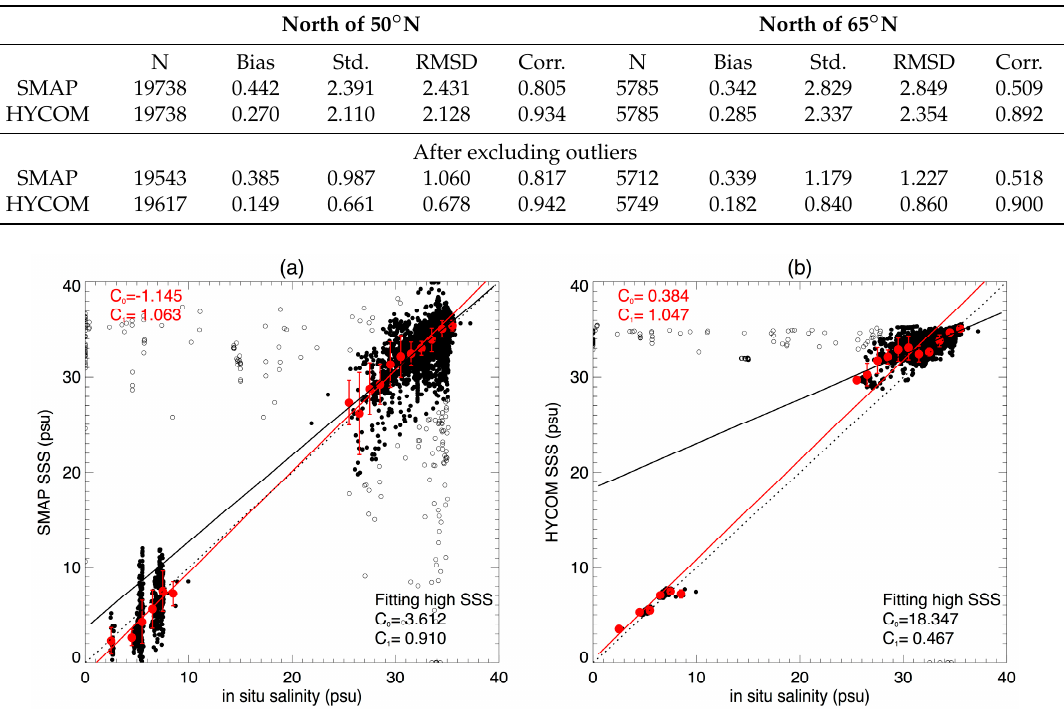
Figure 3. Scatterplot of in situ salinity collected within 5 m from surface and collocated data of ( a ) SMAP SSS and ( b ) HYCOM SSS. Collocations are based on gridded data on 0.25 ◦ grids averaged daily from April 2015 to March 2018. The three clusters associated with low in situ salinity (2–7 psu) are located in the Gulf of Bothania and the Baltic Sea. Open circles indicate where the absolute difference between the pair exceeds three times of the standard deviation. Linear regression of all data (excluding outliers) bin-averaged in terms of in situ SSS (bin size of 1 psu) is illustrated in red with zero intercepted denote by C 0 and slope by C 1 , while the regression of high SSS (>25 psu, excluding outliers and the low salinity clusters.) is illustrated in black. Red dots indicate bin-average and vertical error bars indicate ± 1 standard deviation in the bin. Dotted line indicates the diagonal for reference.